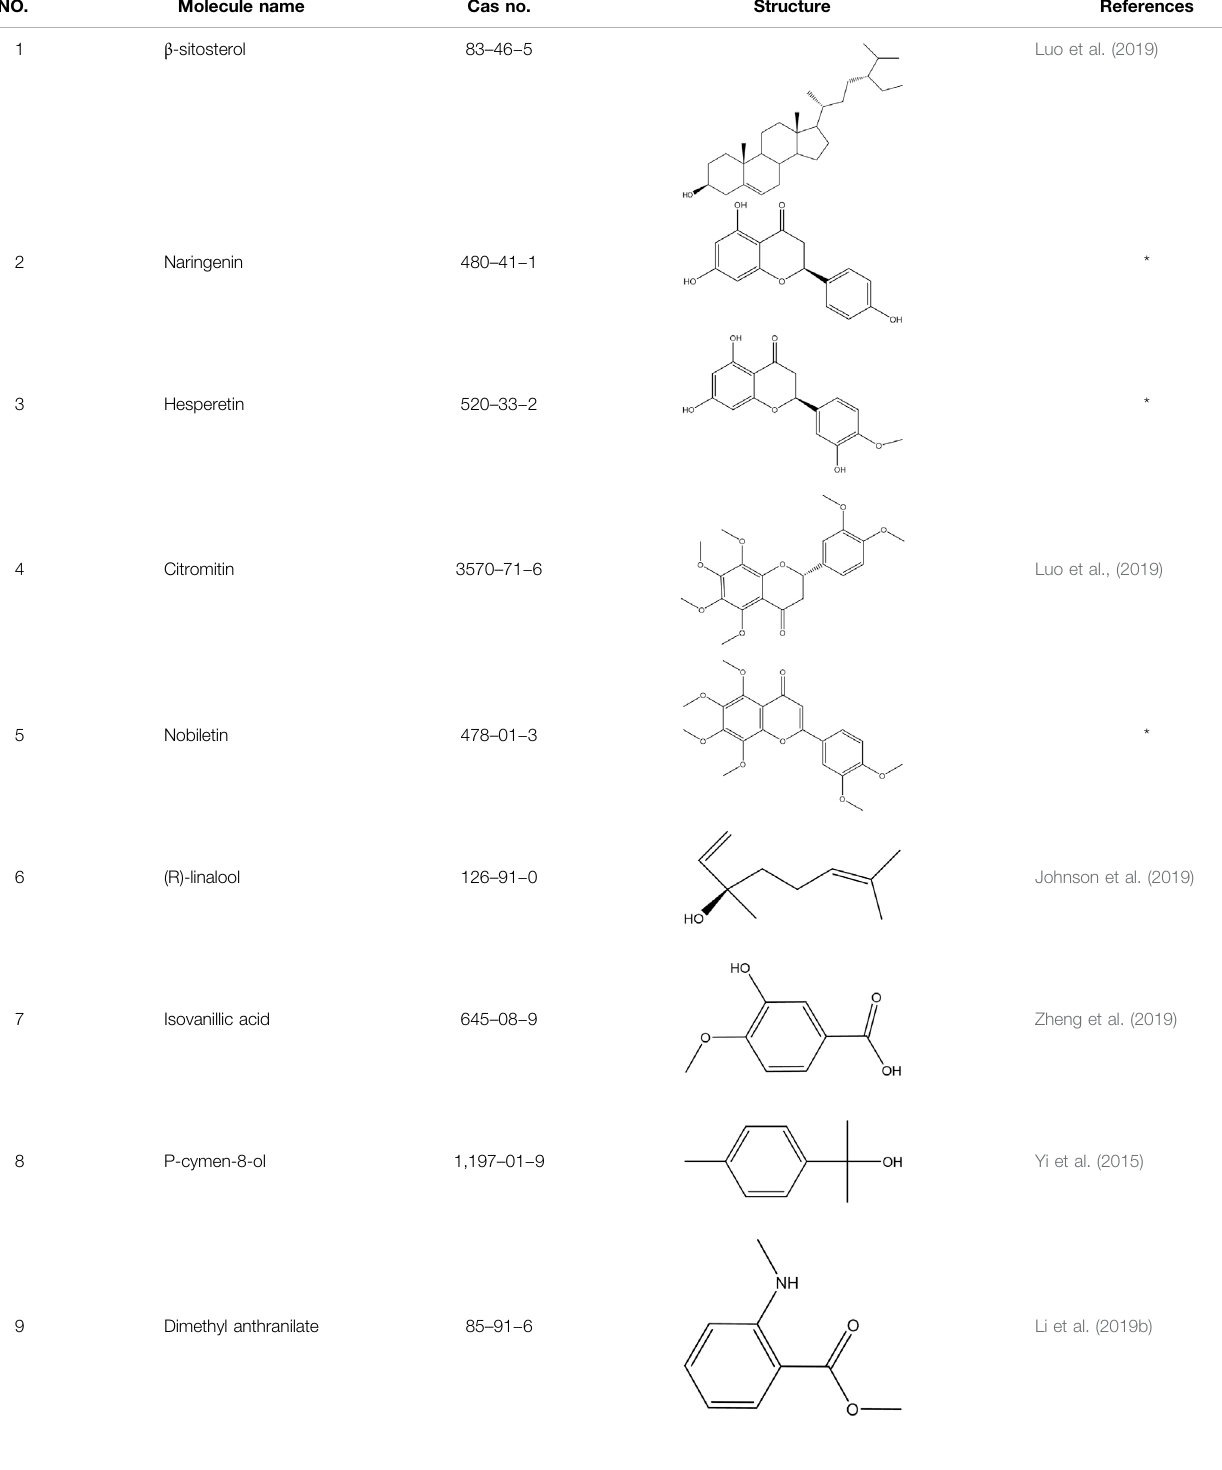
TABLE 2 | | Final selected compounds per the details of the active compounds in